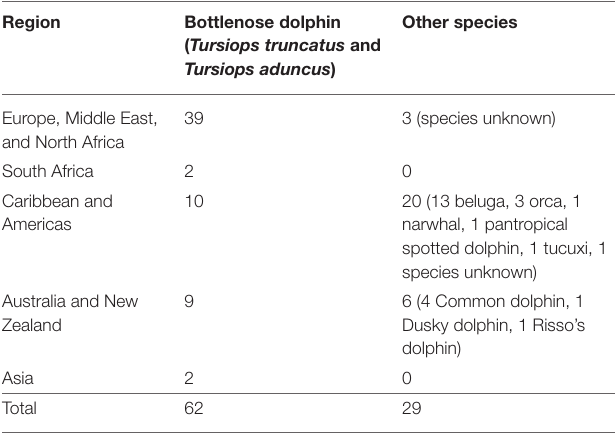
TABLE 1 | Solitary-sociable dolphins 109AD − 2008 by region and species [adapted from Goodwin and Dodds (5)]. Other species Region Bottlenose dolphin ( Tursiops truncatus and Tursiops aduncus ) Europe, Middle East, and North